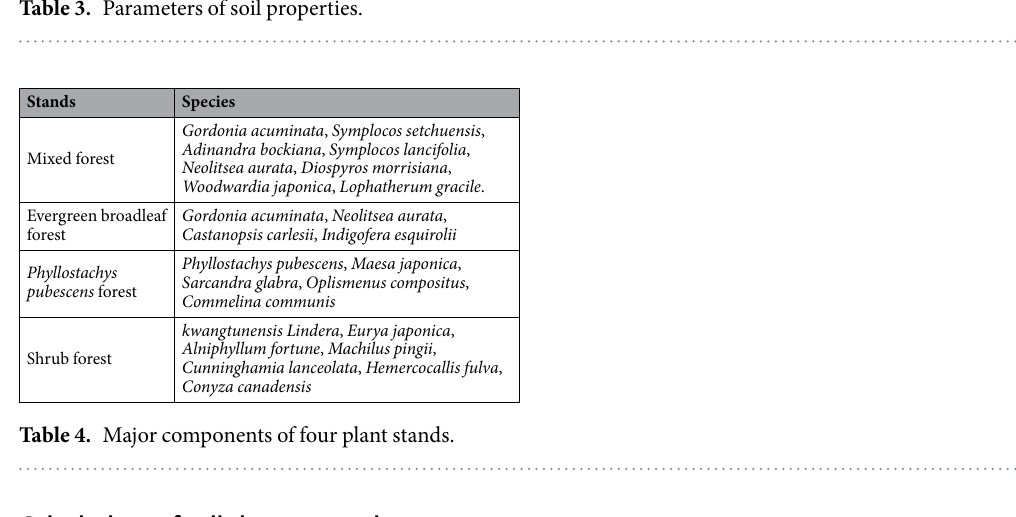
Table 3. Parameters of soil properties.